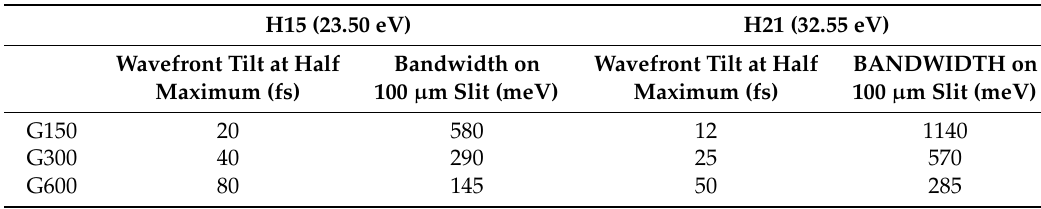
Table 2. EUV wavefront tilt given by the three gratings for H15 and